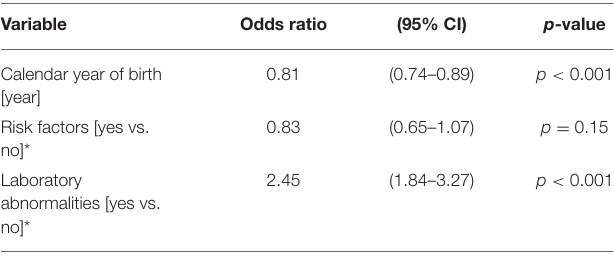
TABLE 4B | Ordered logistic regression: duration of antibiotic therapy by calendar year of birth, risk factors, and laboratory